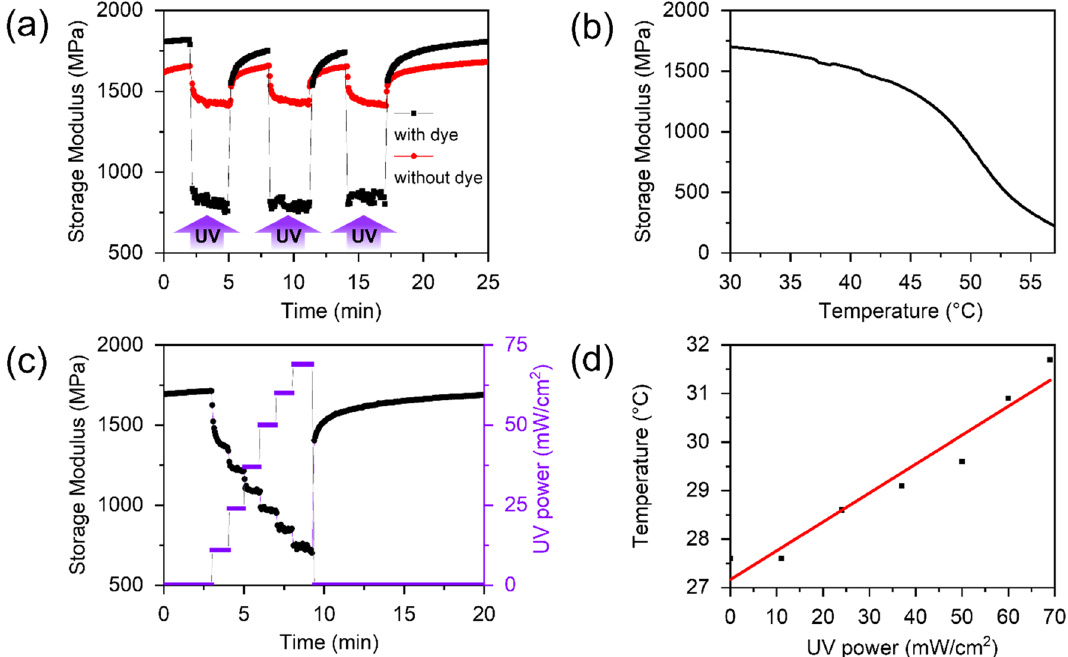
Figure 3. Storage modulus of chiral-nematic LCN films with and without fluorescent dye under UV illumination with 3 min intervals and power ~ 50 mW/cm 2 ( a ). Modulus-temperature relation (without illumination) for the identical sample ( b ). Storage modulus change of dye-containing chiral nematic LCN film using different UV power intensities ( c ) and corresponding temperature changes